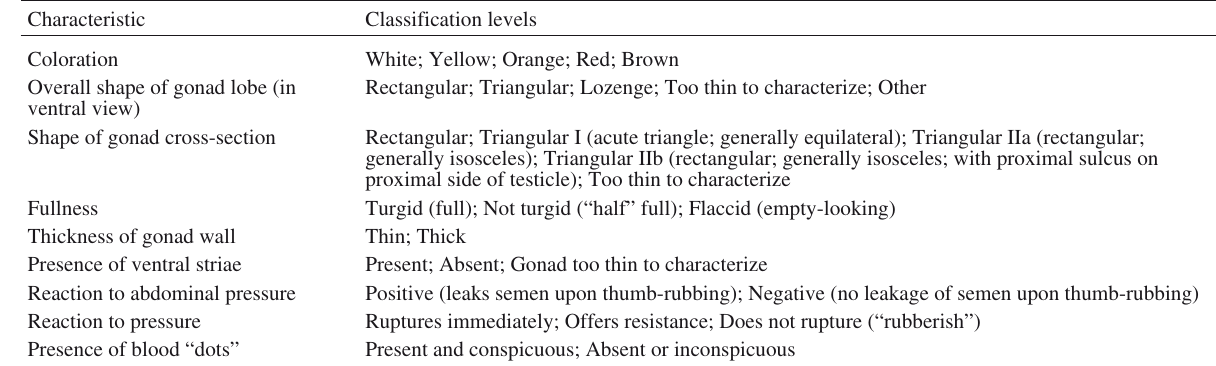
Table 1. – Main characteristics used in the macroscopic analysis of meagre